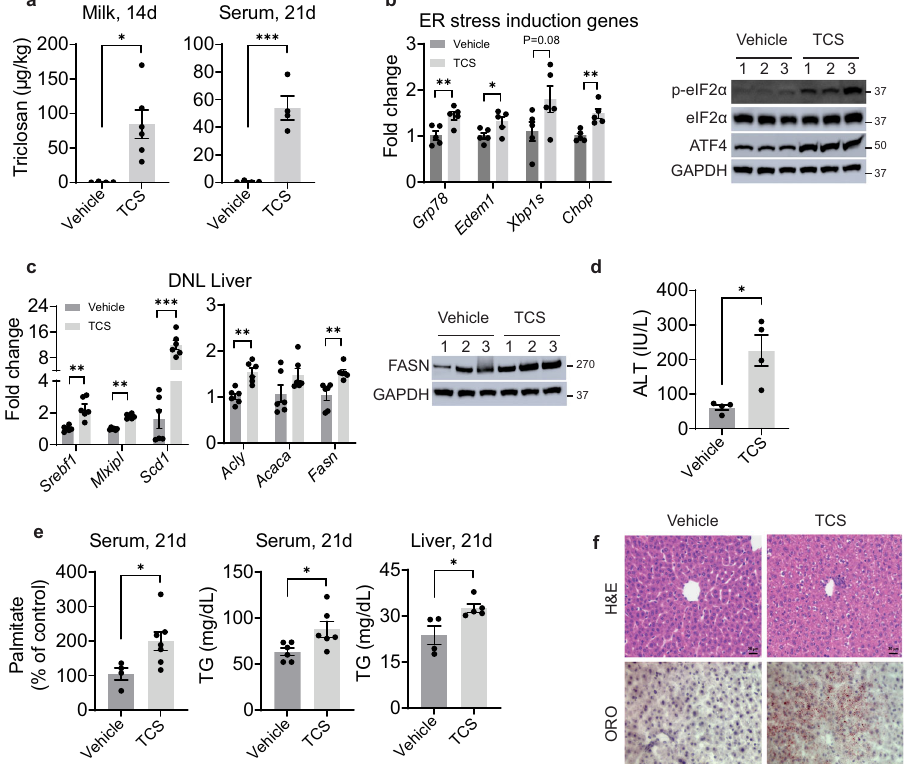
Fig. 1 | Triclosan exposure induces ER stress, stimulates DNL and causes TG accumulation. WT micebreastfed with TCS or vehiclefor14 or21 days. a TCS was measuredinmilkfromstomachcontentsof14-dayoldmice(Vehicle n =4and TCS n =6 per group) and serum at21 days ( n =4 pergroup). b Expression of hepatic ER stress genes ( n =5 per group) and immunoblot (IB) analysis of total and phos- phorylated eIF2 α and ATF4 in liver lysate from 21-day old mice ( n =3 mice per group). c Expression of hepatic lipogenic genes at 21 days ( n =6 mice per group)